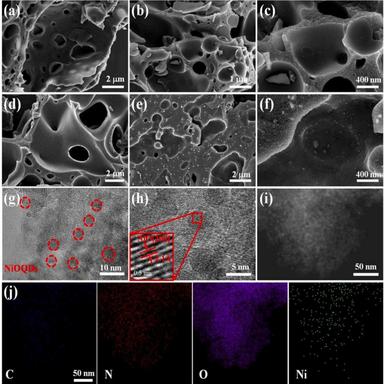
(a-c) SEM images of HCA; (d-f) SEM images of NiOQDs-2/HCA; (g-h) HRTEM images of NiOQDs-2/HCA, and (i-j) EDS elemental mapping images of NiOQDs-2/HCA.